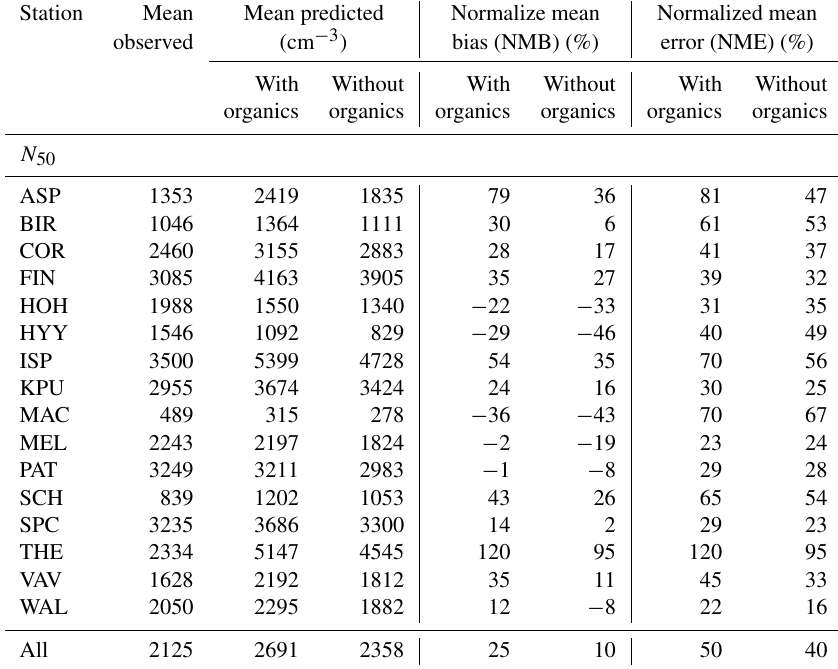
Table 2. Prediction skill metrics of PMCAMx-UF against daily ground measurements of particle number concentration with a diameter above 50nm from 16 stations during 5 June–8 July